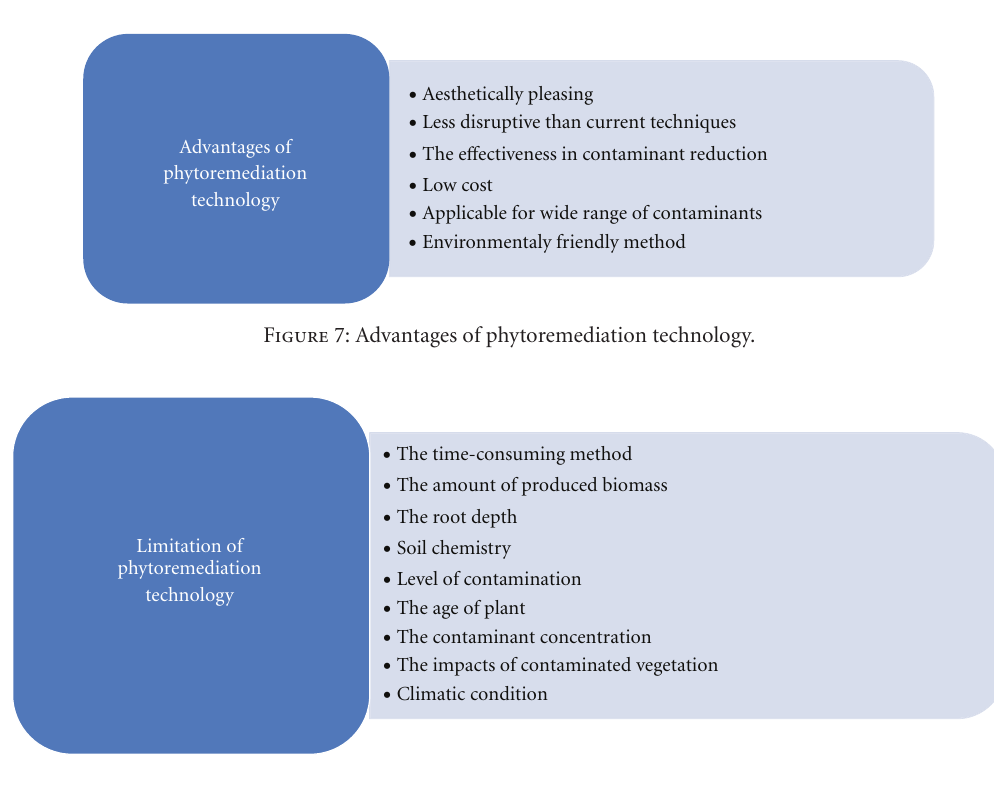
Figure 8: The limitation of phytoremediation